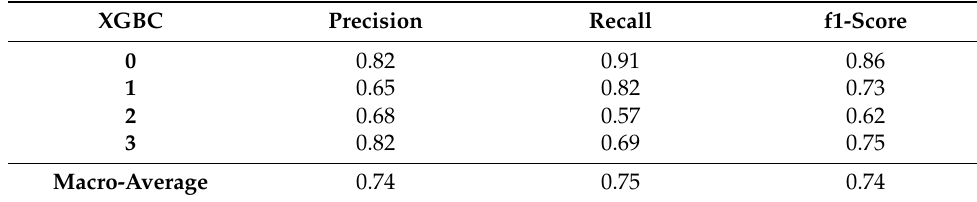
Table 11. Performance of XGBC.